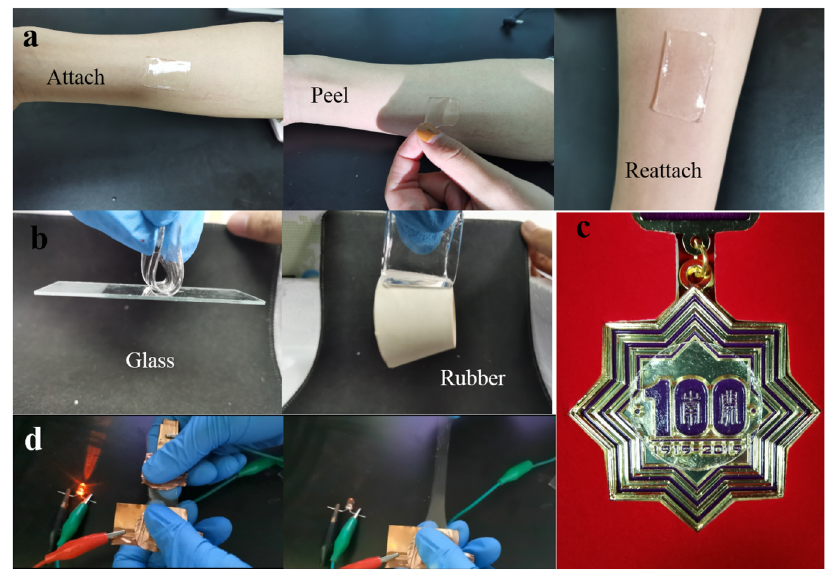
Fig. 6 Adhesion and conductivity test of hydrogel. a Hydrogel could adhere to the skin. (Hy- α -CD-ACA-PEG 20000 -ACA/Ca hydrogel; ACA-PEG 20000 - ACA: Hy- α -CD = 1:5). b The hydrogel exhibited universal adhesiveness on material surfaces of glass and rubber. c Optical photo of a transparent hydrogel covering the Nankai University 100th Anniversary emblem. d Hydrogel could conduct electricity to brighten the bulb, and the bulb would become darker when the hydrogel was stretched.